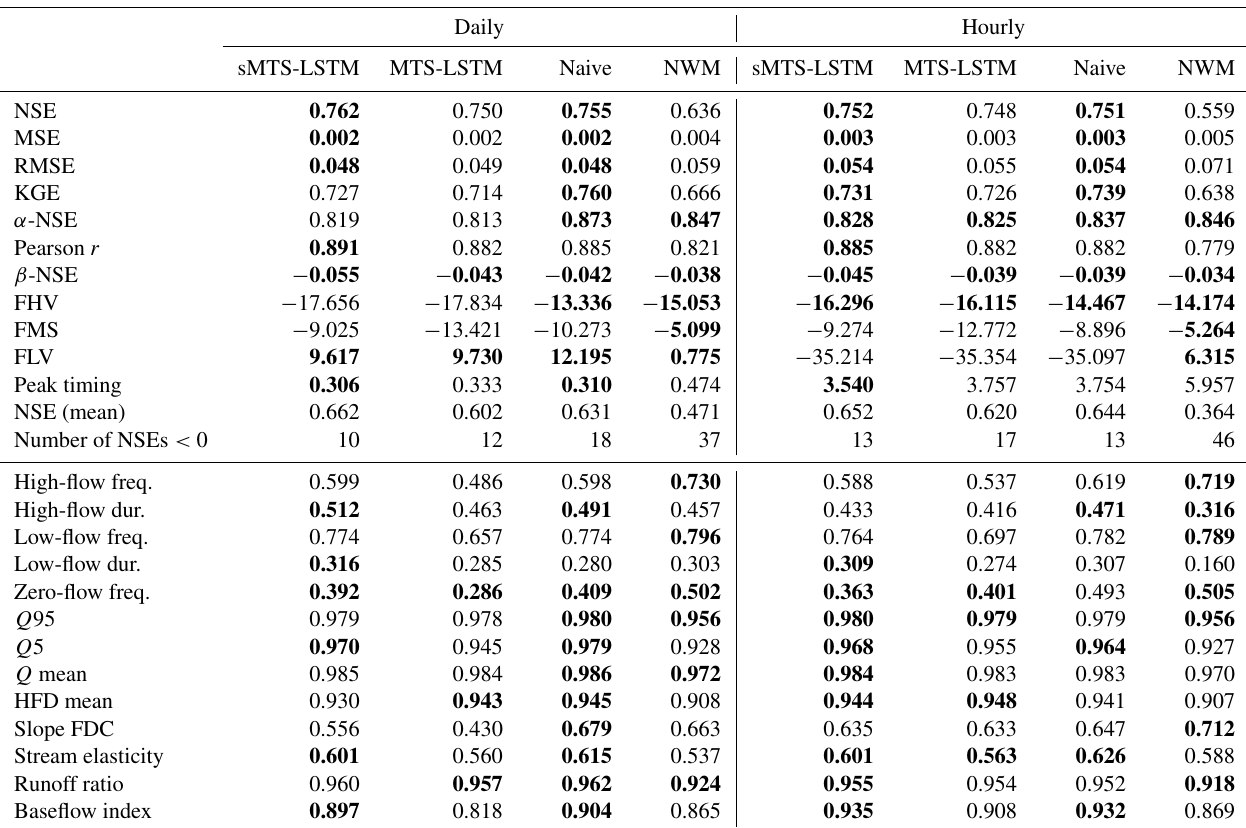
Table 4. Median metrics (upper table section) and Pearson correlation between signatures of observed and predicted discharge (lower table section) across all 516 basins for the sMTS-LSTM, MTS-LSTM, naive daily and hourly LSTMs, and the process-based NWM. Bold values highlight results that are not significantly different from the best model in the respective metric or signature ( α = 0 . 001). See Table 3 for a description of the metrics and signatures.